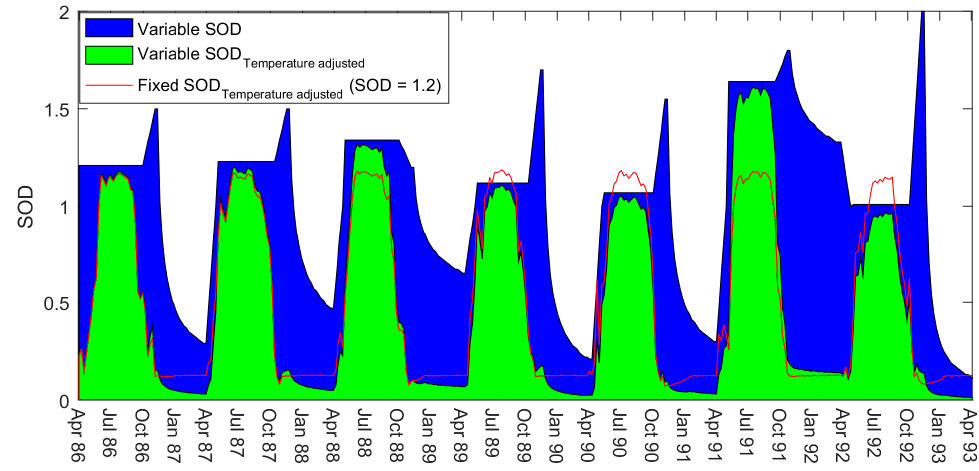
Figure 7. A comparison of the maximum SOD rates that we input into the model (blue) against the temperature adjusted rates that the model is actually using based on W2 default values for the four temperature-rate multipliers (green). Also shown is the temperature adjusted rates for the fixed SOD simulations.